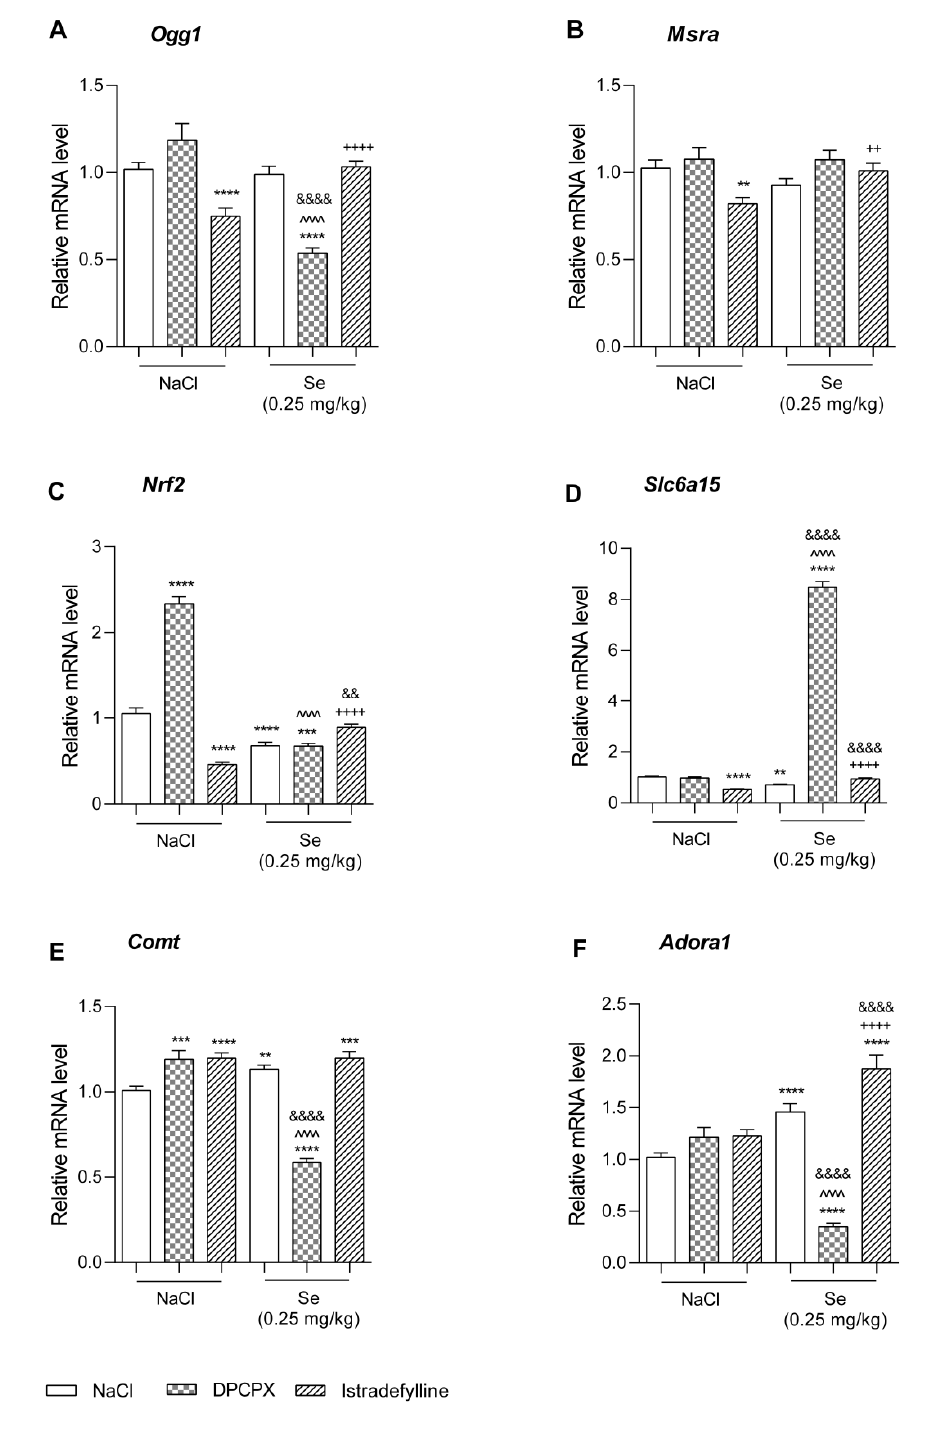
Figure 4. Effect of combined administration of sodium selenite and selective adenosine receptor antagonists on the expression of gens in murine prefrontal cortex: ( A ) Ogg1 , ( B ) Msra , ( C ) Nrf2 , ( D ) Slc6a15 , ( E ) Comt , ( F ) Adora1 . DPCPX, sodium selenite (Se), and NaCl 0.9% were administered i.p. 30 min, while IST was administered p.o. 60 min prior behavioral testing. Data are presented as the means ± SEM. Each experimental group consisted of 8–10 mice. ** p < 0.01, *** p < 0.001, **** p < 0.0001 vs. NaCl; ^^^^ p < 0.0001 vs. DPCPX; ++ p < 0.01, ++++ p < 0.0001 vs. IST; && p < 0.01, &&&& p < 0.0001 vs. Se (two-way ANOVA followed by Bonferroni’s post hoc test).